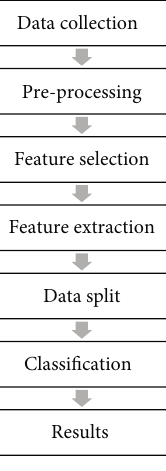
Figure 1: Proposed work fl ow